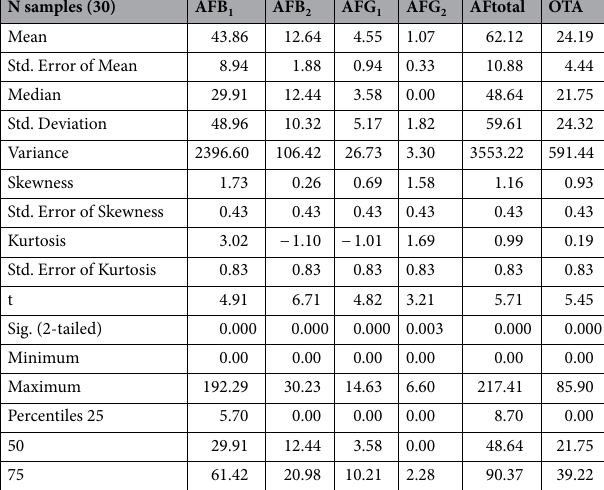
Table 13. Statistical summary of data obtained from the Western Region of Ghana.